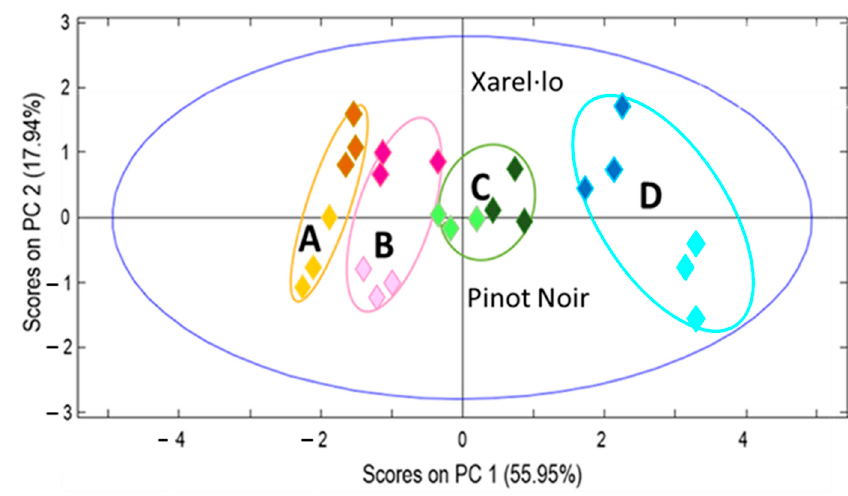
Figure 5. Characterization of sparkling wines aged for a period of seven months by PCA using the compositional profiles of amines as the data. Scatter plot of scores of PC1 vs PC2. Dark colors correspond to Xarel·lo.